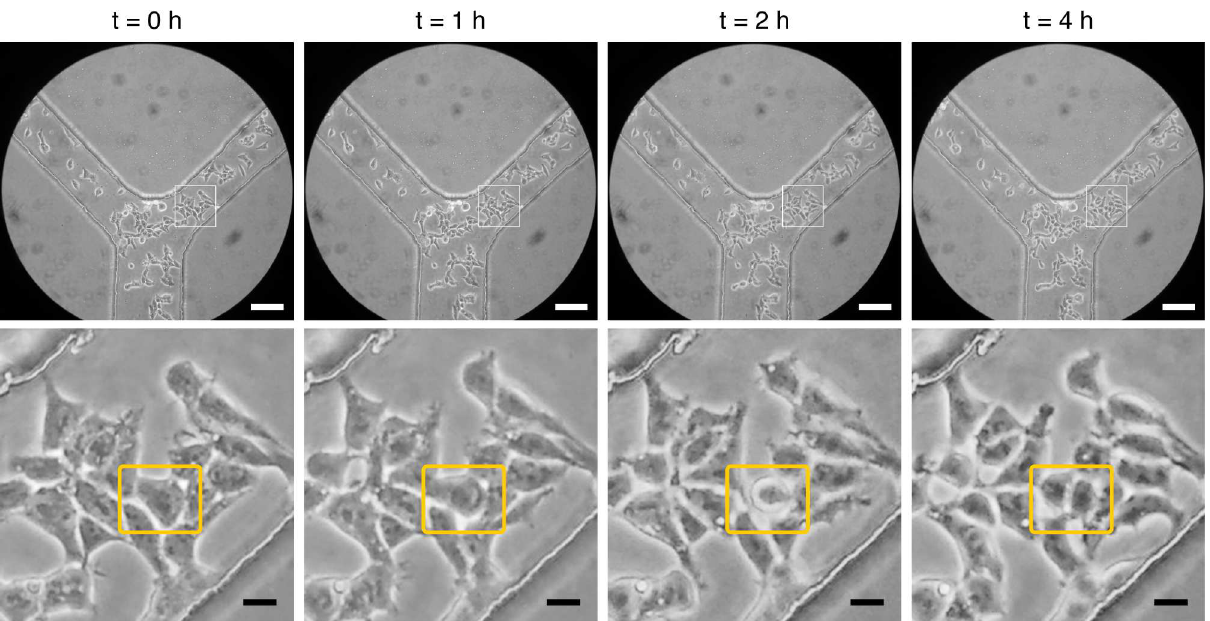
Fig 7. Imaging of HEK cells grown in microfluidic channels. HEK cells were imagedfor 4 h with a SamsungGalaxy S I9000 using the ATLIS with the humidifying module (recirculating-loopconfiguration) mountedon a Nikon TMS microscope with 10X magnification in the eyepieceand using a 20X objective.No signs of evaporation were detected in the microfluidic system and the cells moved and proliferated normally. White boxes delineatemagnifiedareas shown in the bottom row. A proliferating cell can bee seen in the area marked by a yellow box . The lower channelwas 250 μ m across, whilethe narrowerchannelsat the top were 125 μ m wide. All channelswere 100 μ m in height. Scale bars: white 100 μ m; black 20 μ m.